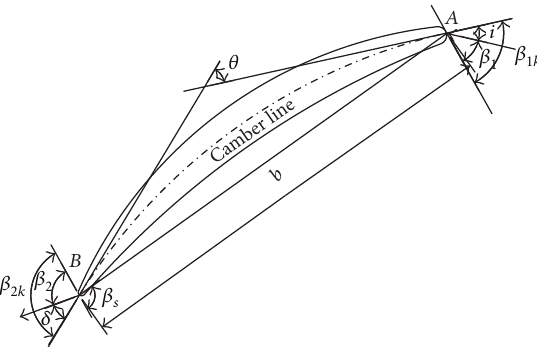
Figure 4: Geometric parameters of blade section curve.